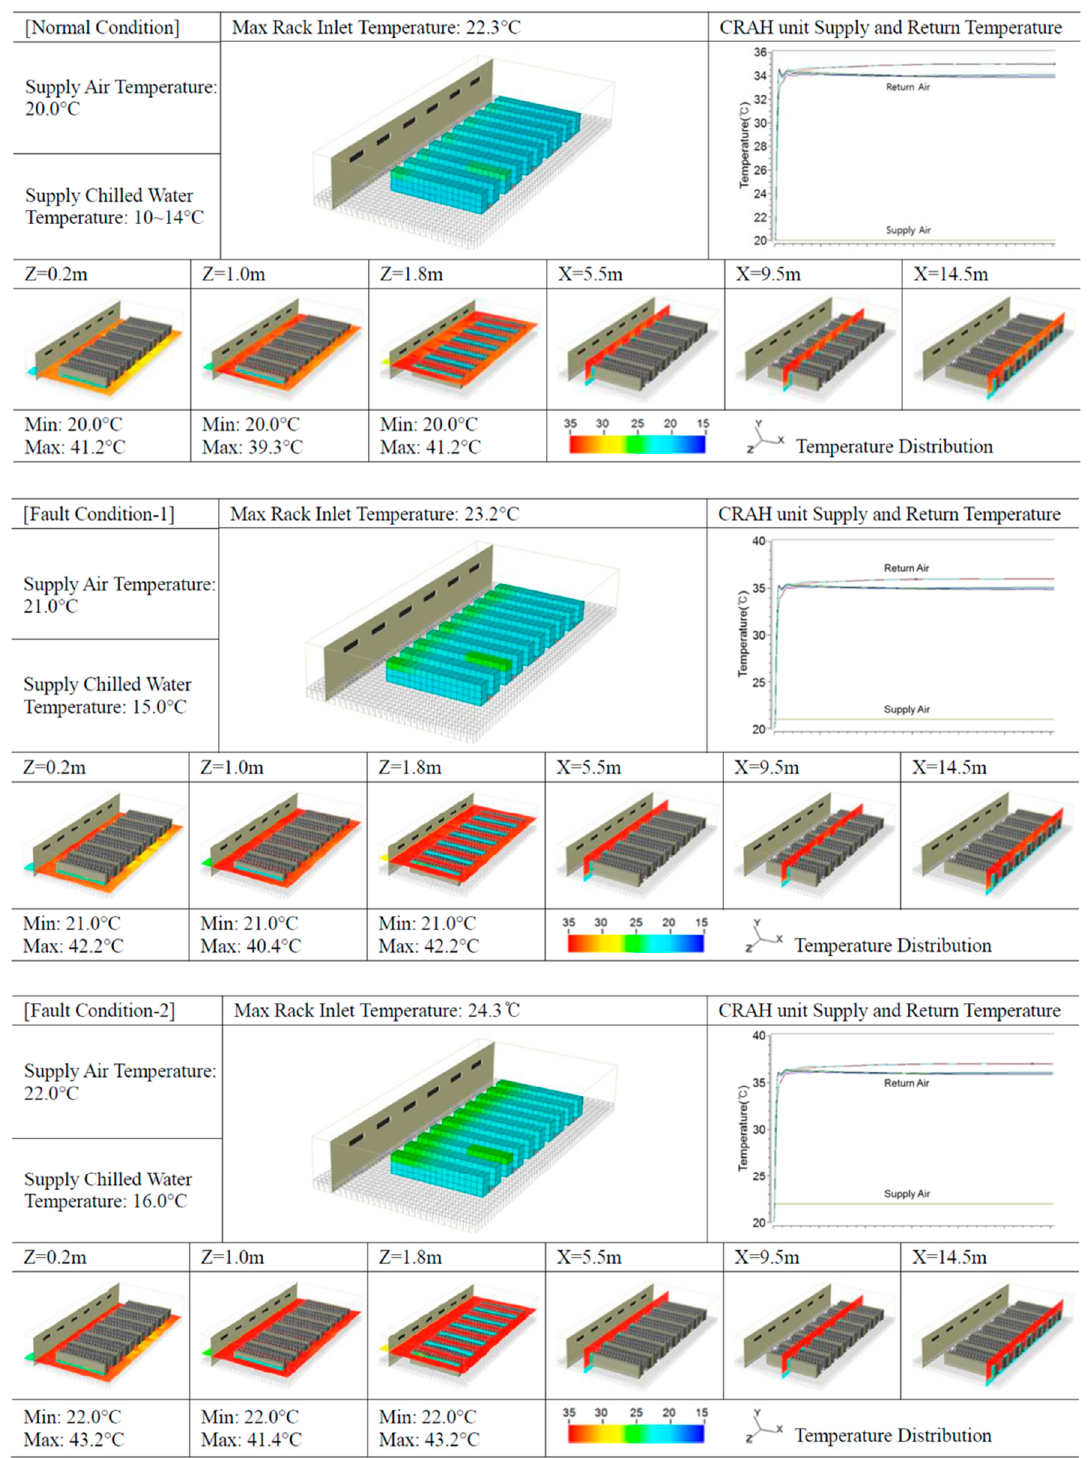
Figure 10. CFD simulation results for normal conditions and fault conditions 1 and 2.